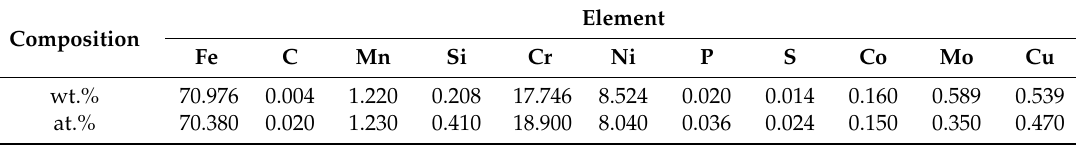
Table 1. Chemical composition of 304 L stainless steel (wt.% and